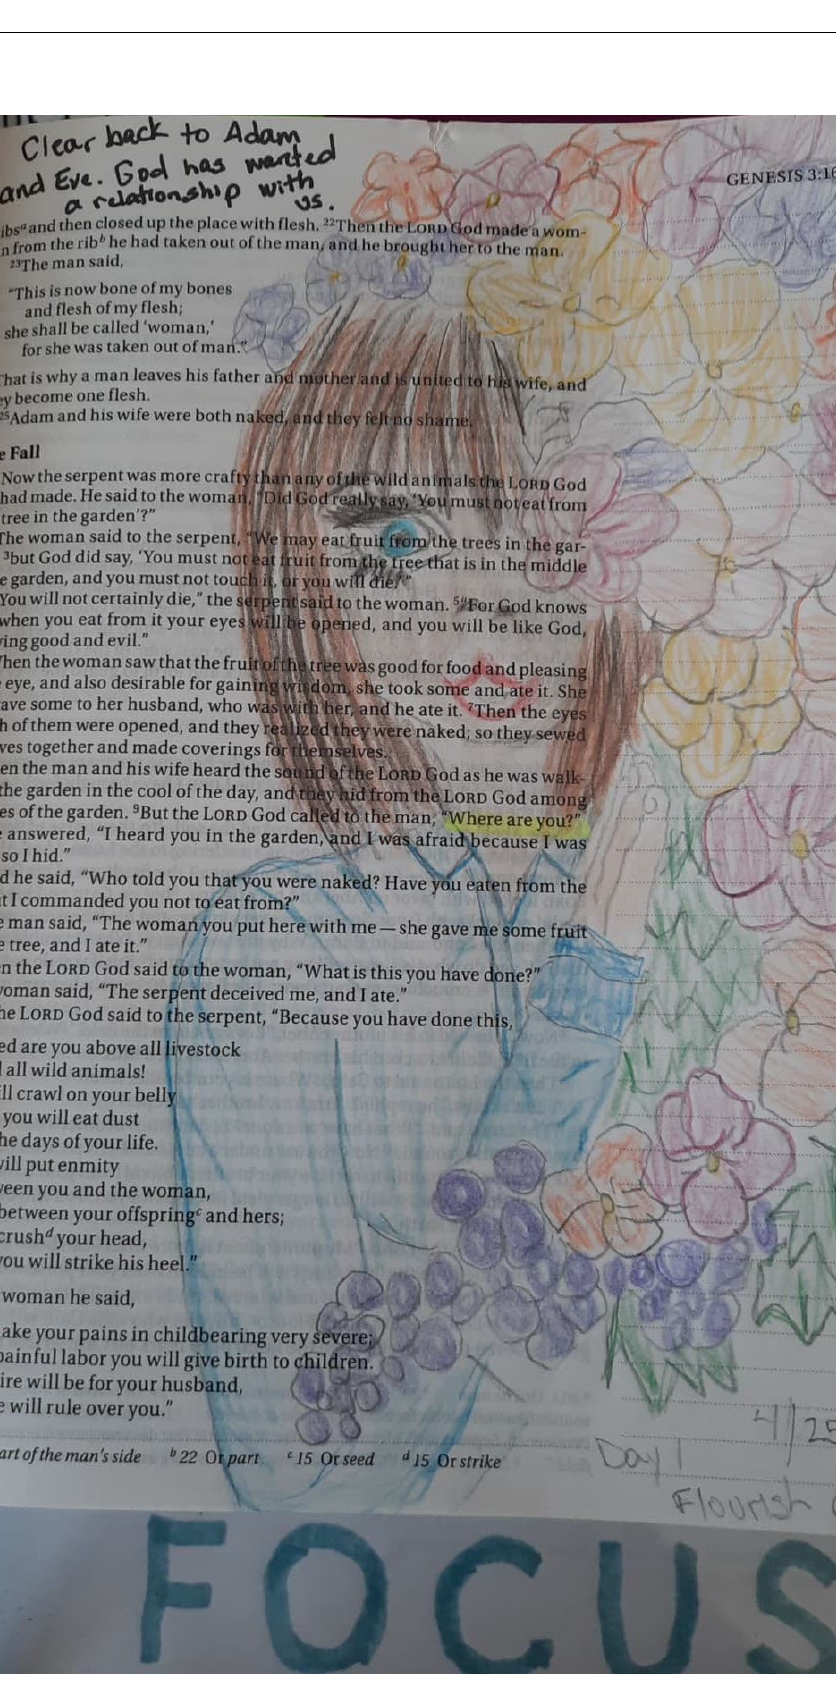
Figure 3. Genesis 3:9. With kind permission of the journaler.